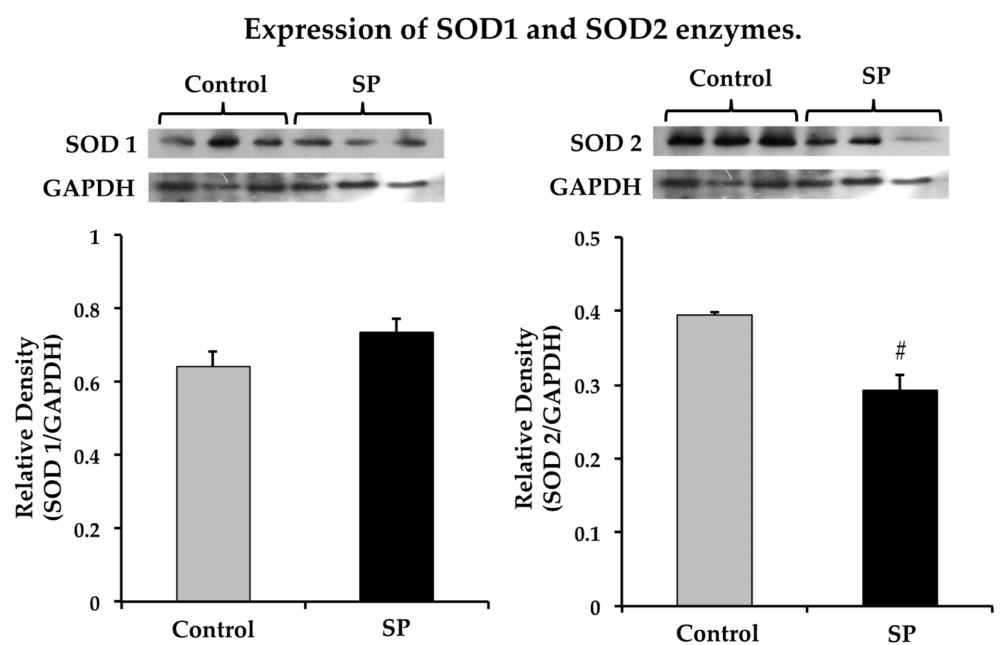
Figure 6. Superoxide dismutase 1 and 2 expression in the homogenized tissue from the thoracic aorta from control and sucrose period (SP) rats. Data represent mean ± SEM, # p < 0.05, n = 4 (4 different homogenates from pools of 3 aortas from different rat pups and litters). A representative Western blot analysis is shown above the